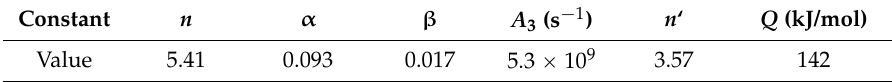
Table 2. Material constants for the alloy, which were evaluated from the constitutive equations.